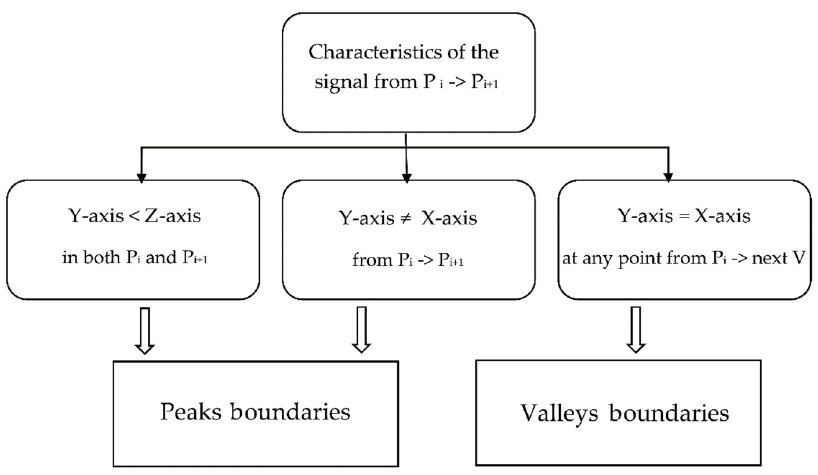
Figure 5. Determining boundary type based on signal characteristics (P: Peak; V: Valley).